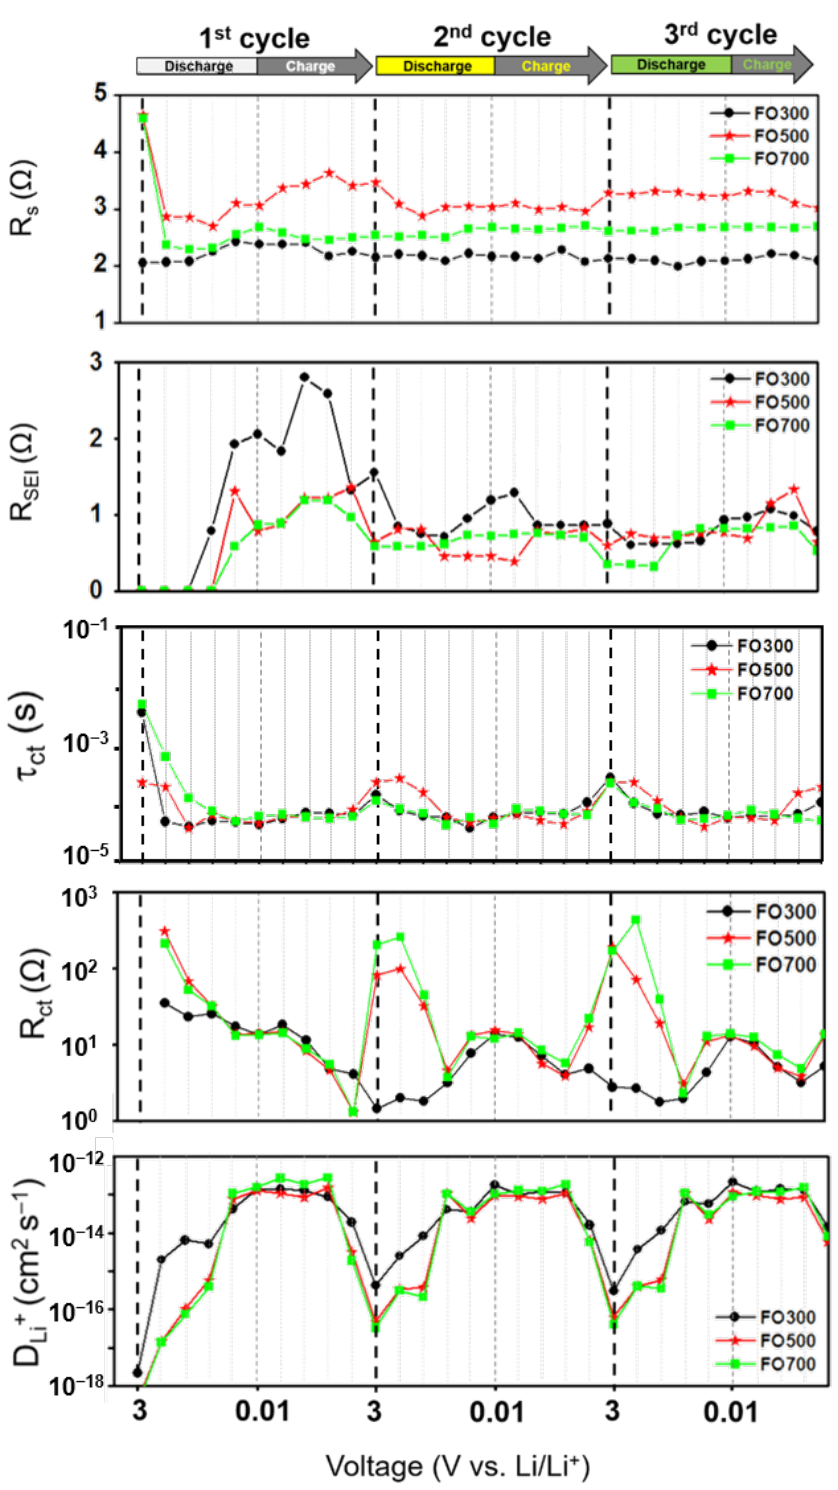
Figure 5. Parameters (R s , R SEI , R ct , τ ct , and D Li + ) obtained by fitting and calculation using equiv- alent circuits and Equations (1)–(3) at each voltage: the α -Fe 2 O 3 nanofibers were annealed at 300, 500, and 700 ◦